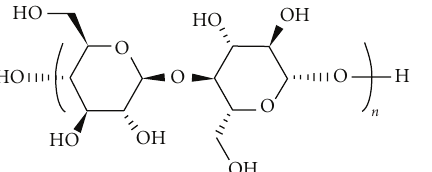
Figure 3: Molecular structure of the carboxymethyl cellulose (CMC).